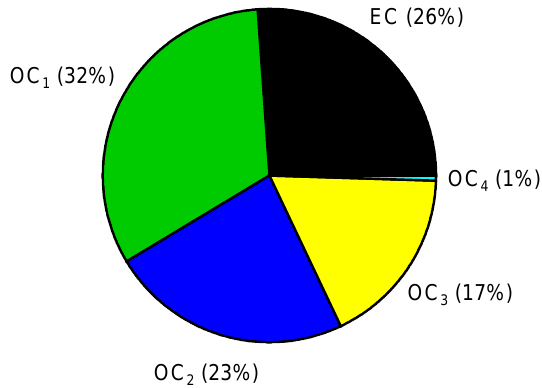
Figure 4. Average mass fractions of EC, OC 1 , OC 2 , OC 3 and OC 4 in PM 2 . 5